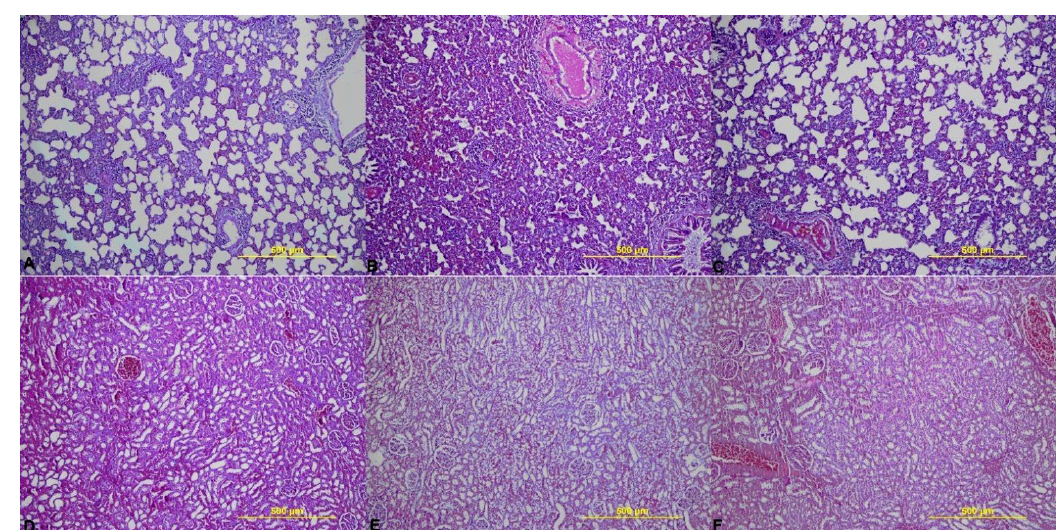
Fig. 4 - A and D show renal and lung tissues samples of the sham group and there were no pathological changes. B) shows lung tissues samples of control group and neutrophil and leukocyte infiltration with alveolar congestion were observed. E) shows renal tissues samples of control group and tubular damage characterized by cast formation; the loss of brush border and interstitial edema were observed. C and F show lung and renal tissues samples of thymoquinine treated group and there were less severe lesions than in the control